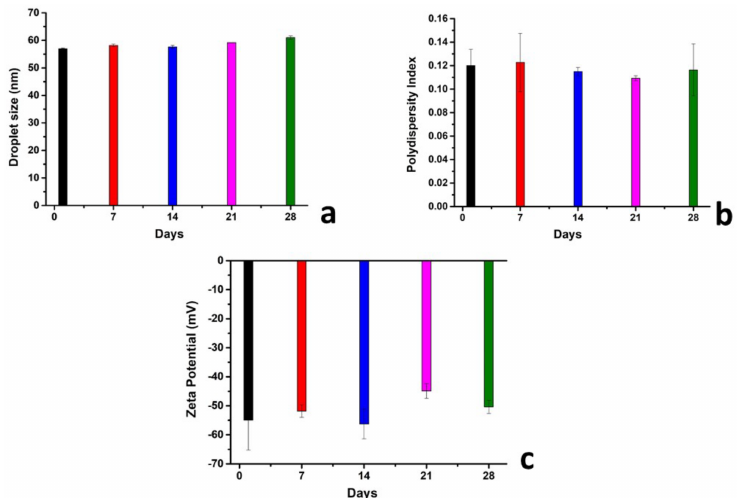
Figure 14. Droplet size ( a ), polydispersity index ( b ), zeta potential ( c ) values over 28 days of EFV-LNC stability